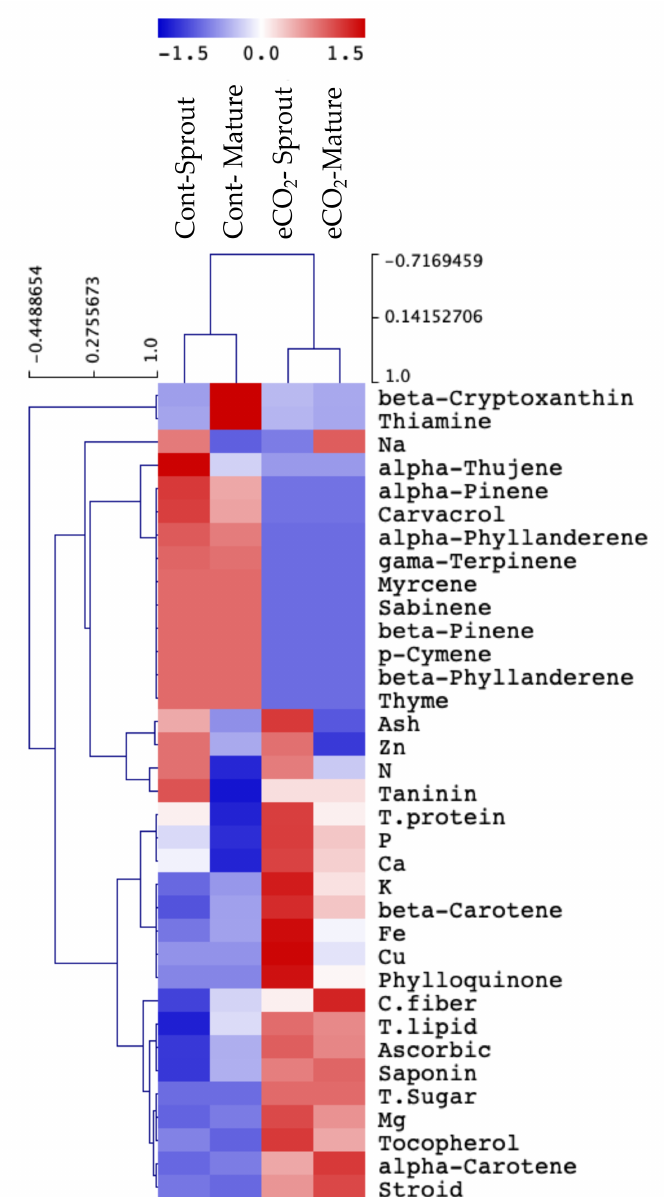
Figure 2. Hierarchical clustering analysis of total nutrients, minerals, vitamins and essential oils of control and eCO 2 -treated caraway sprouts and mature plants. Data are represented by the means of at least 3